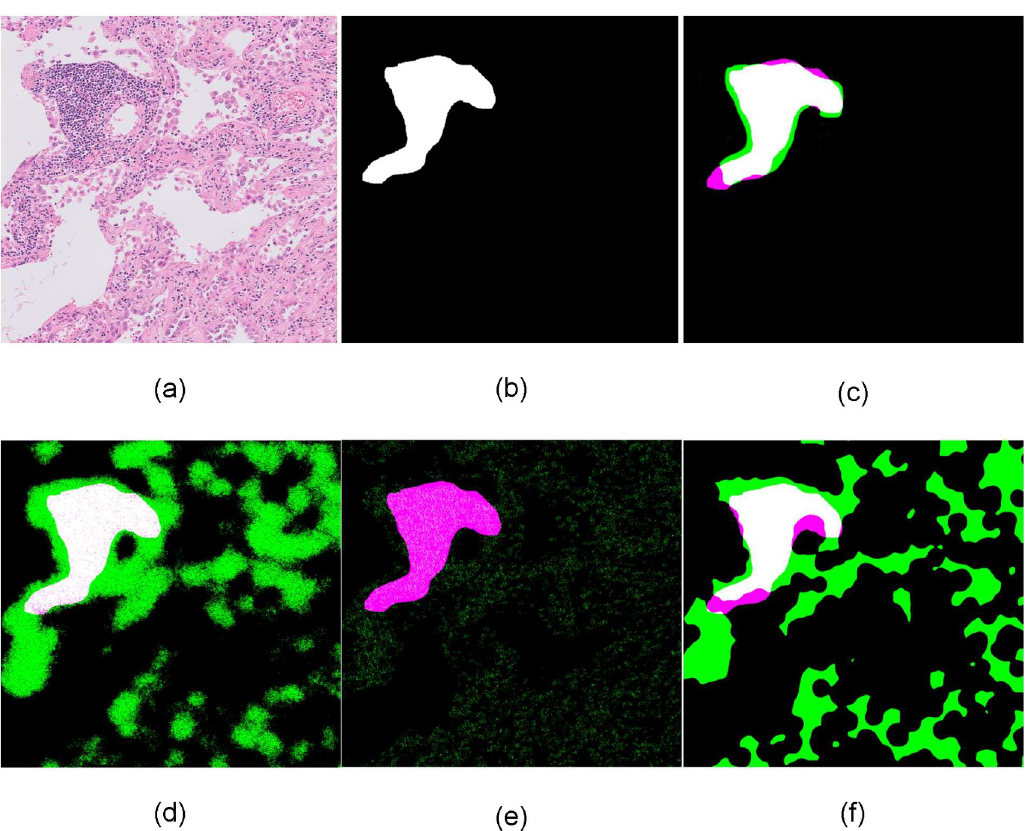
Fig 6. Qualitative comparison on tissue slide-based analysis. a) input 10x H&E-stained image, b) ground truth c) DeepLabv3 + identified TLS regions, d) SegNet identified TLS regions, e) U-Net identified TLS regions, f) lymphocytes density thresholding identified TLS regions, in comparison with ground truth: White color (True Positive), green color (False Positive), magenta color (False